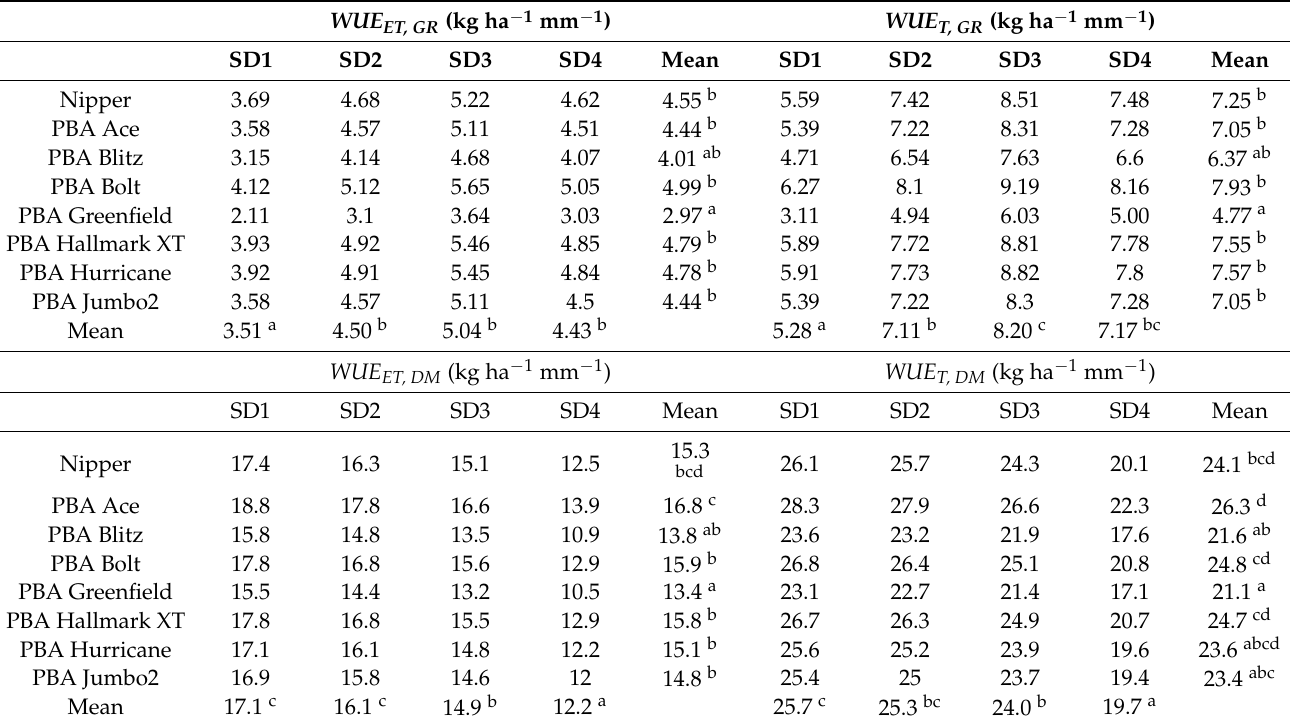
Table 7. Calculated values of water use efficiencies for grain yield and biomass accumulation from the fitted linear mixed models. Different letters indicate significantly different values. The values for the genotypes at each sowing date (SD) are the means of three